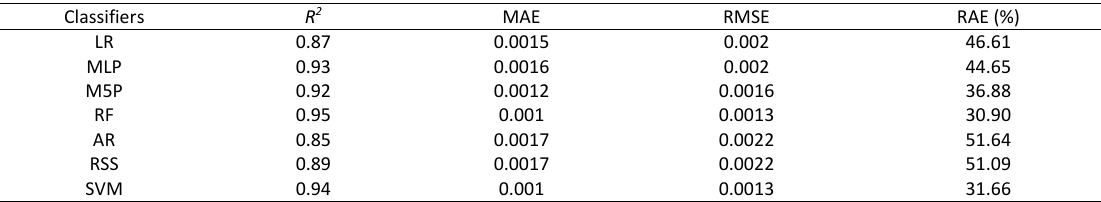
Table 2: Prediction performance of different algorithms